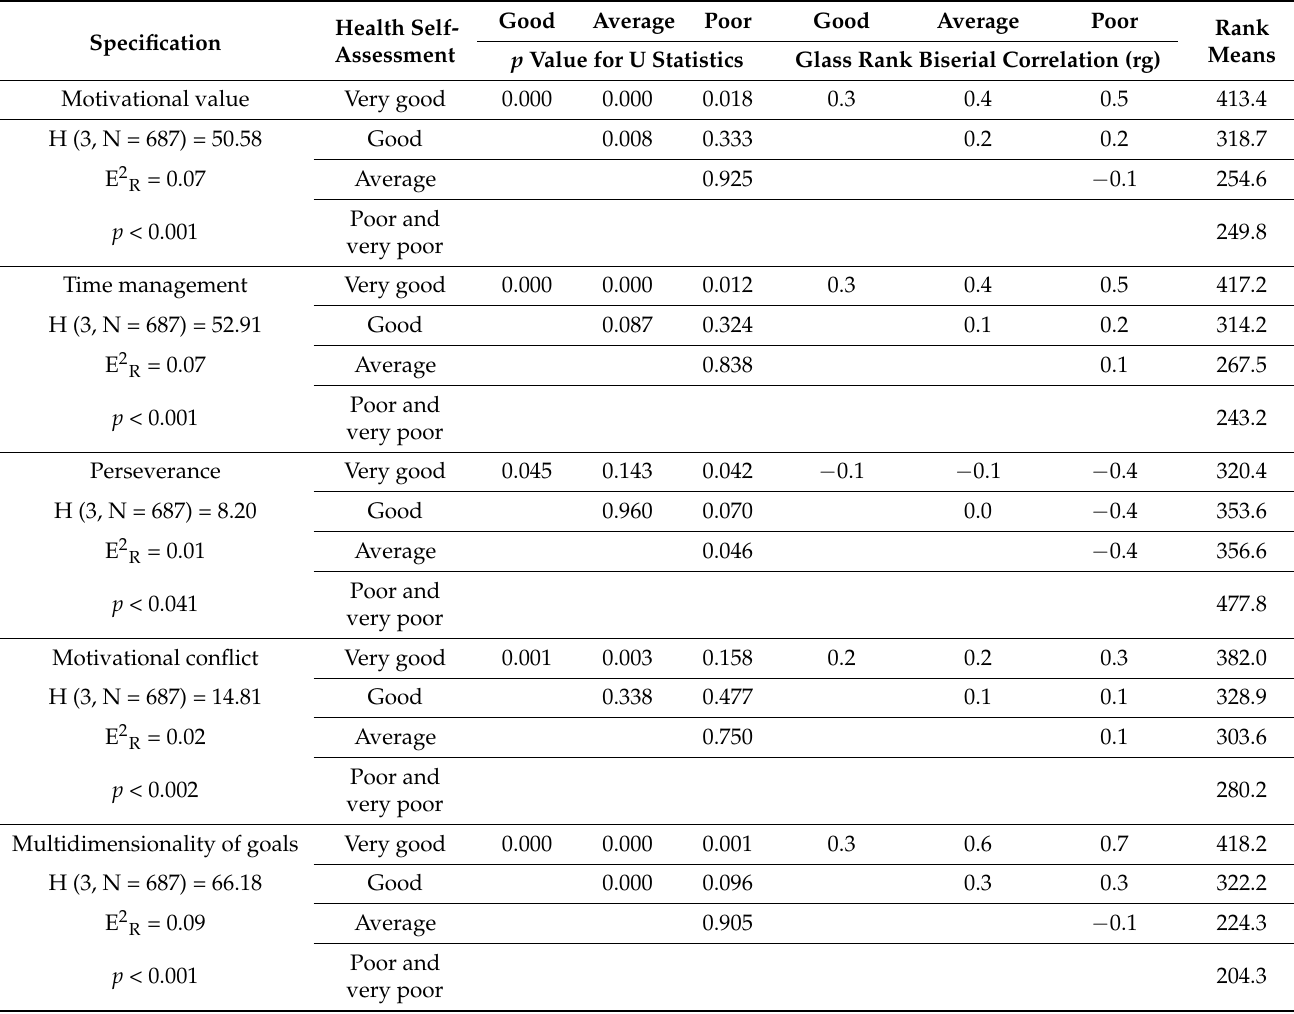
Table 5. Motivational functions of physical activity goals (IPAO), depending on the self-assessment of health of the respondents (H test, E 2 R, U test,